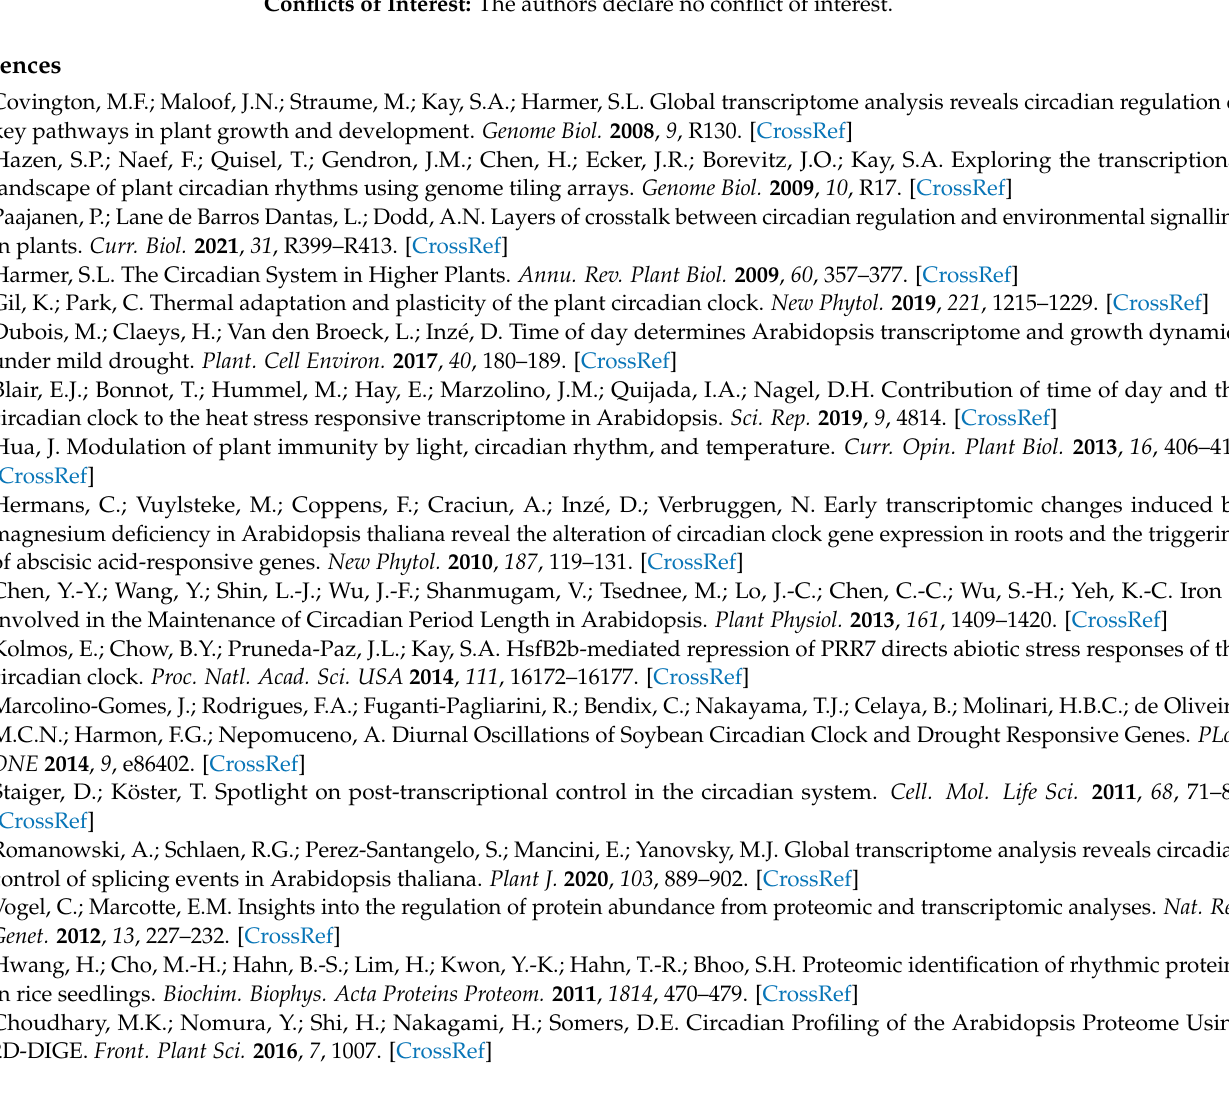
Table S2: All identified proteins and